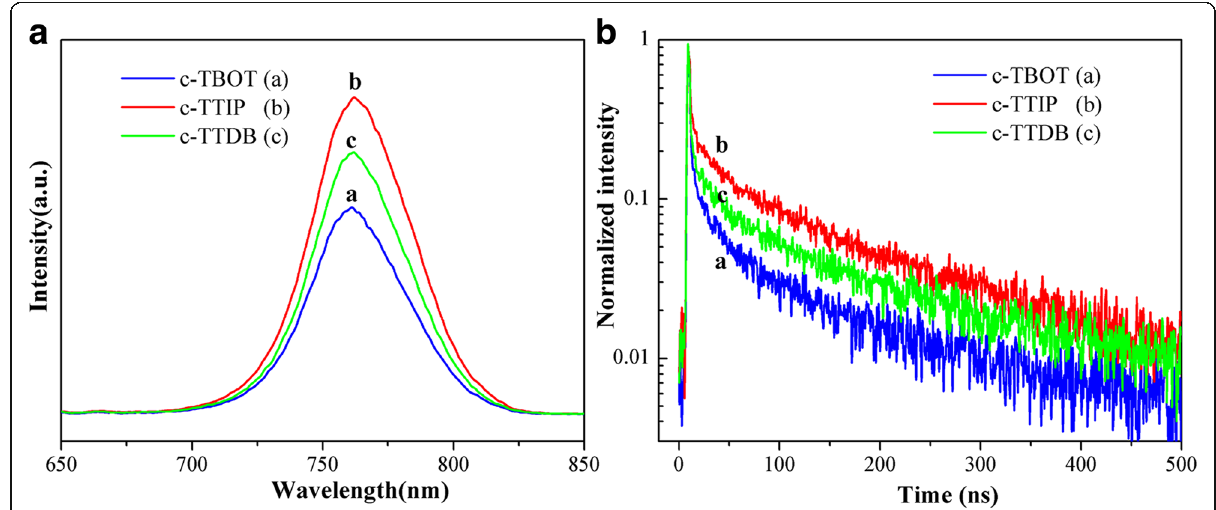
Fig. 6 a PL and b TRPL of perovskite films based on different compact